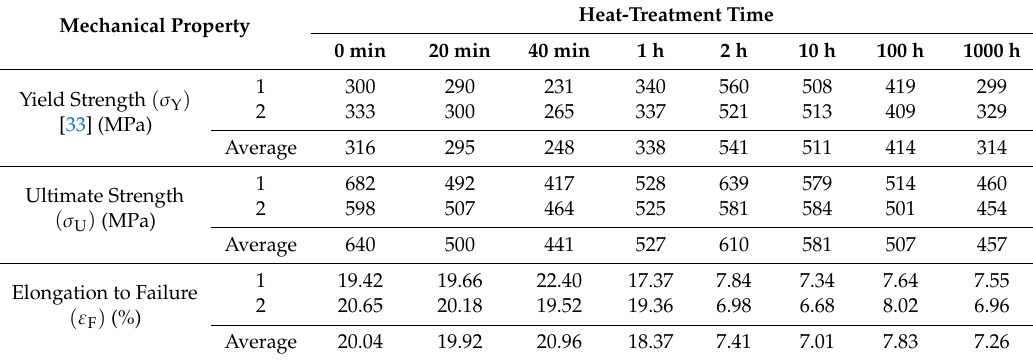
Table 1. Yield strength ( σ Y ) [33], ultimate strength ( σ U ) , and elongation to failure ( ε F ) . Mechanical